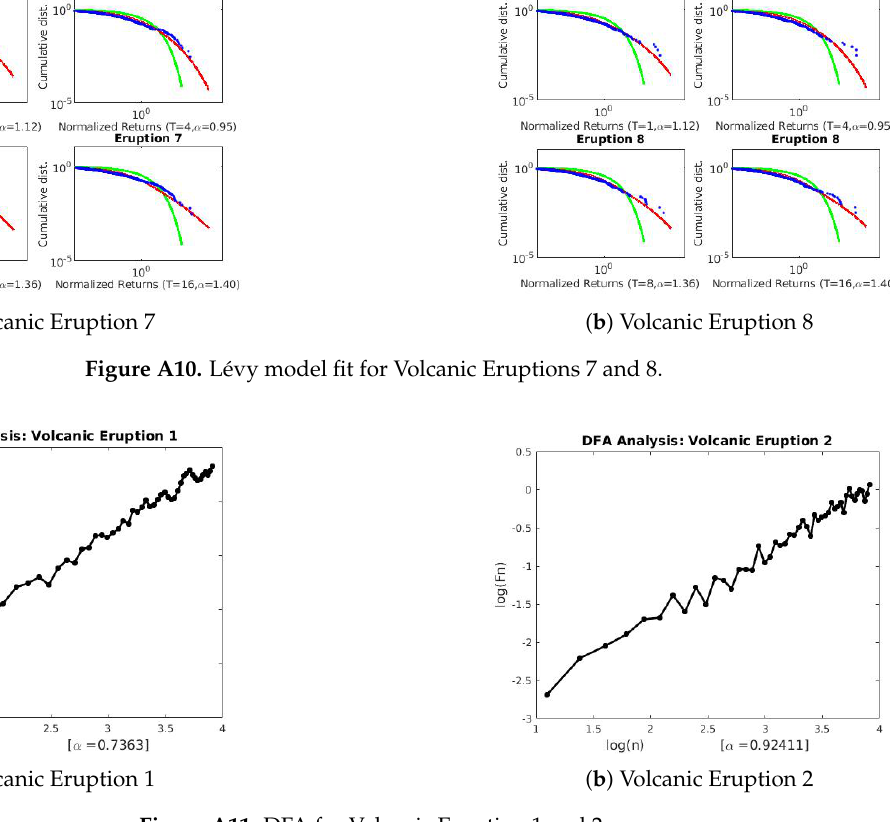
Figure A11. DFA for Volcanic Eruption 1 and 2.